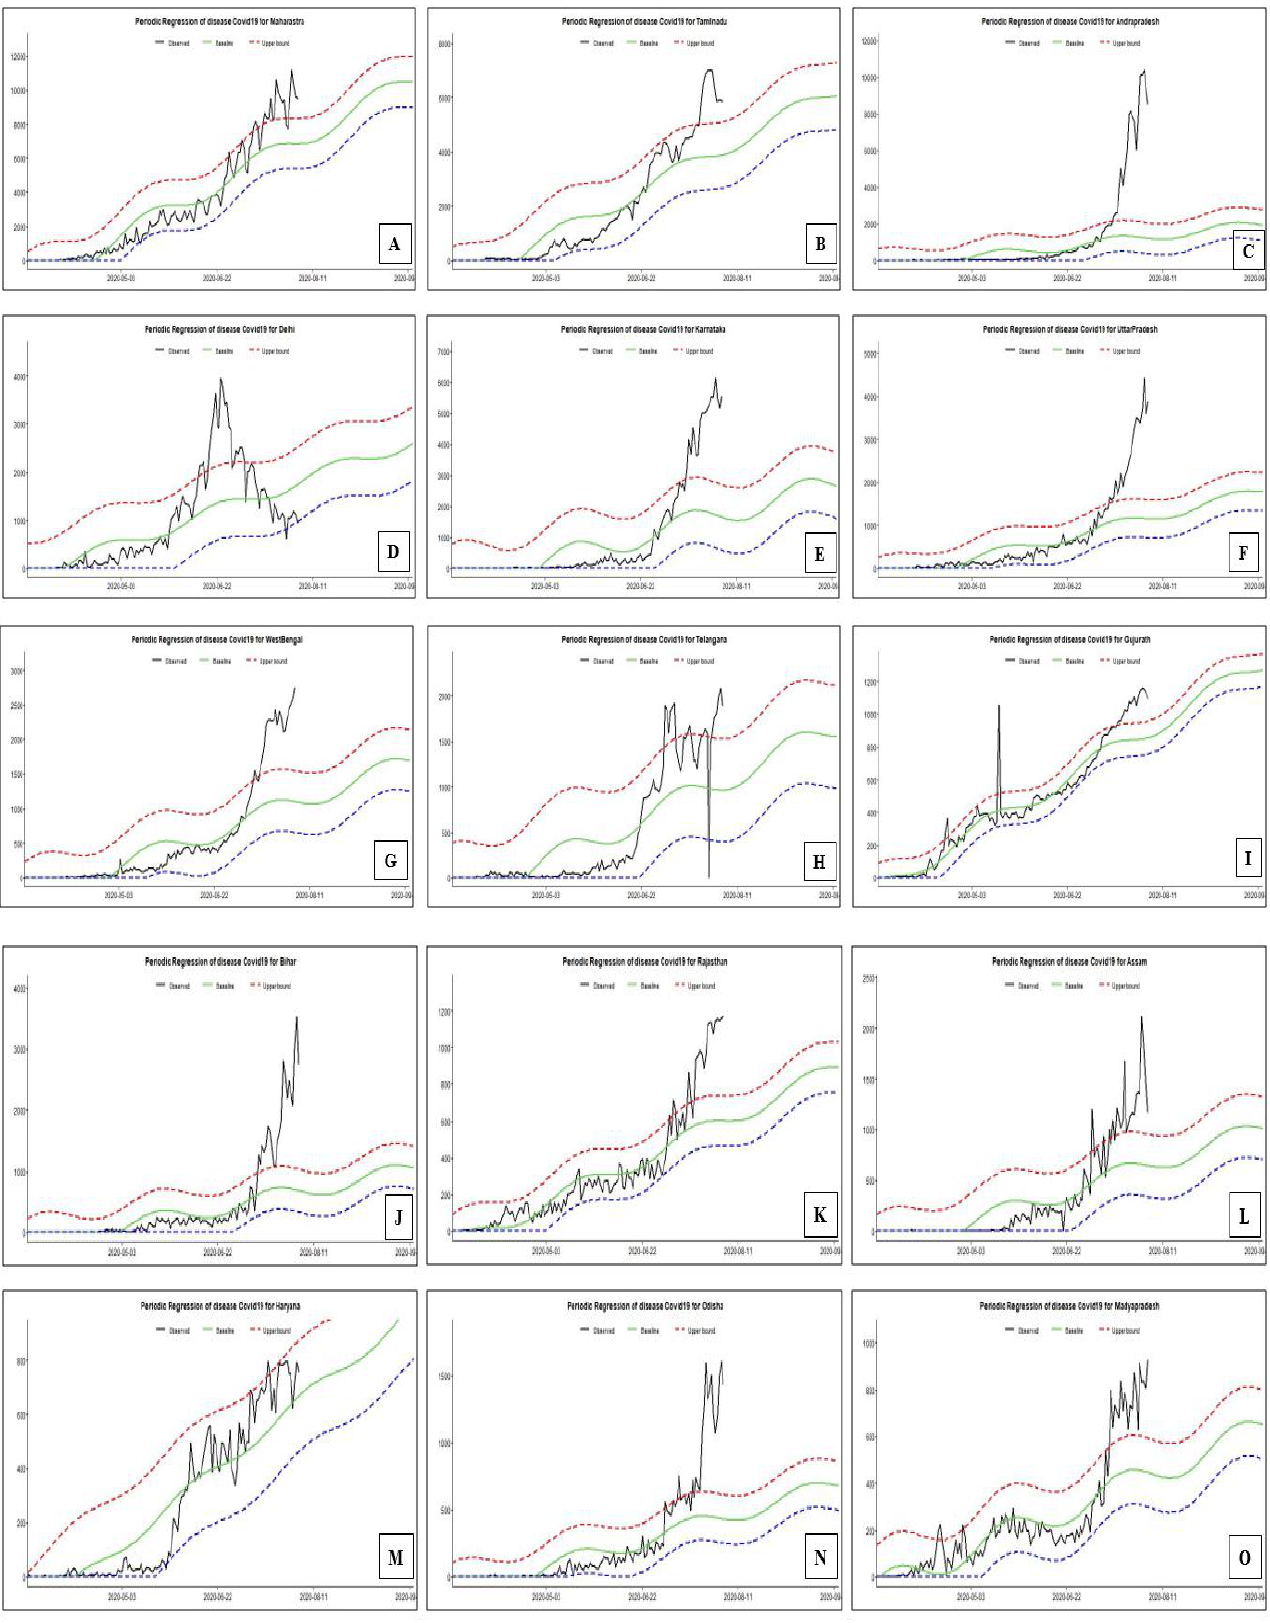
Figure 1: Periodic regression analysis of COVID-19 disease outbreaks in the top 15 highly infected states in India- Maharashtra (A), Tamil Nadu (B), Andhra Pradesh (D), Delhi (C), Karnataka (E), Uttar Pradesh (F), West Bengal (G), Telangana (I), Gujarat (H), Bihar (J), Rajasthan (K), Assam (L), Haryana (M), Odisha (N) and Madhya Pradesh